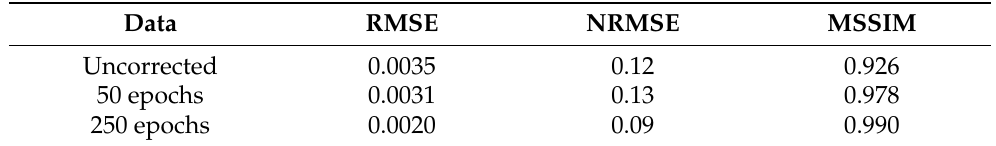
Table 1. Performance of the CNN MAR correction measured as the RMSE, NRMSE and MSSIM, calculated between the input ground truth and CNN corrected data. The results are reported for the uncorrected data and corrected data training the CNN for 50 and 250 epochs.